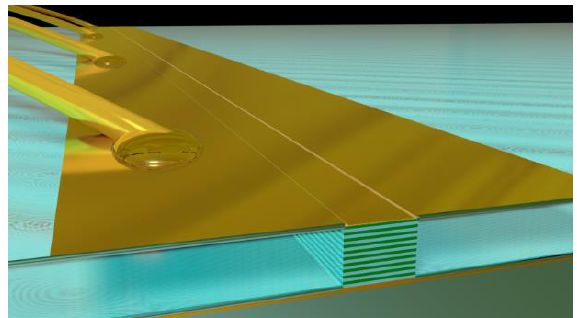
Fig. 1. Illustration of the planarized double metal waveguide geometry, where the active region waveguide (ridge with stripes) is embedded in a low-loss BCB polymer (on the sides). The bonding wires are placed on the extended top contact over the BCB-covered area, which improves the waveguide